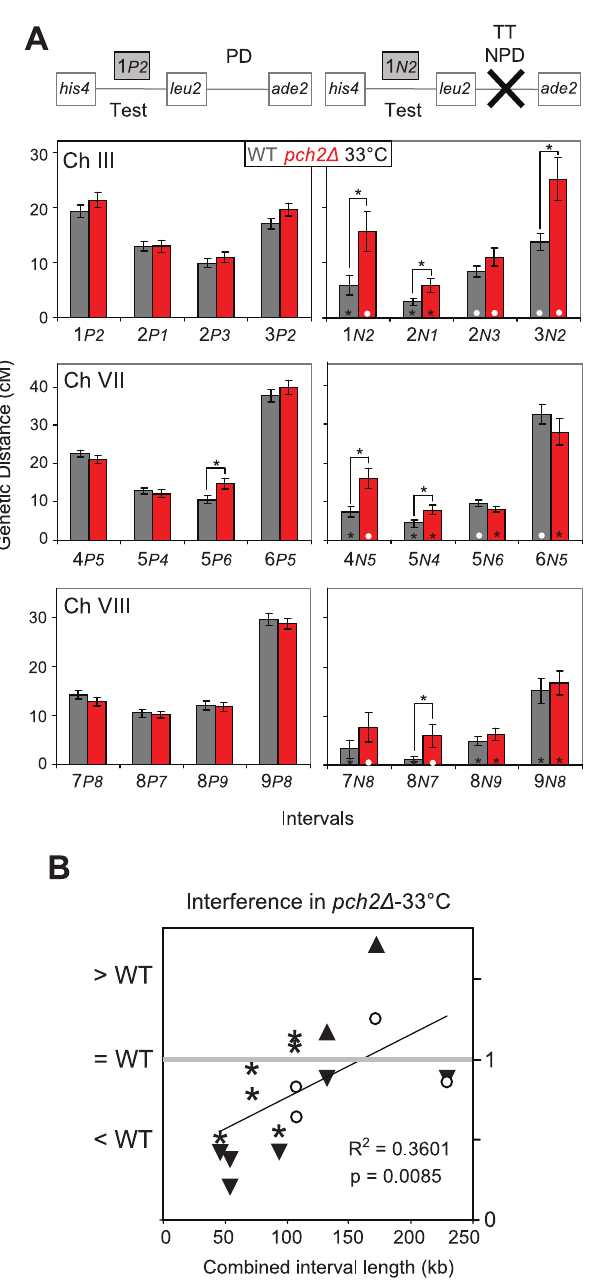
Figure 6. Interference in WT and pch2 D in nine intervals at 33 u C. (A) Modified coincidence analysis. Left column: Map distances for test intervals (=Test) determined from tetrads with parental reference intervals (PD). Right column: Map distances for test intervals determined from tetrads with nonparental reference intervals (TT, NPD). Interval names are given as follows: Test intervals are indicated by the first number in bold, CO status of the reference interval is indicated by the letter in italic ( P =parental; N =nonparental), and reference intervals are specified by the number in italic. For interval numbers see Figure 5A. Error bars are standard errors. Asterisks above bars indicate significant differences for map distances in bracketed intervals between geno- types. Asterisks on bars in right column indicate significant differences between map distances for test intervals within genotypes (indicating interference). White dots on bars in right column indicate lack of significant differences between the same pairs of map distances within a genotype (indicating absence of interference). (B) Strength of CO interference as a function of physical interval size. Combined